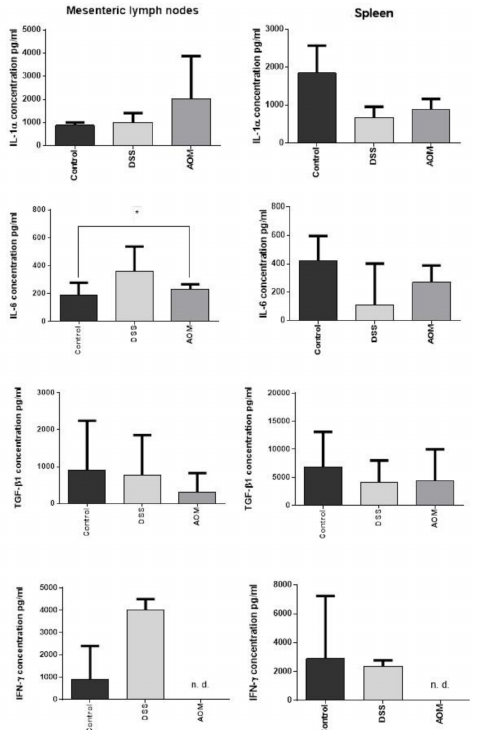
Figure 8. The production of IL-1 α , IL-6, TGF- β 1, and IFN- γ in mesenteric lymph nodes and spleen of DSS- or AOM-induced rats at 1 month from the end of treatments. The cytokine production in MLNs and spleen was indicative of the impact of DSS and AOM on immunity at systemic level. Signs of inflammatory activation were present in MLNs, even at a non-significant level, except for IL-6 after AOM ( p < 0.05). Reduction (even though not reaching significance) of inflammatory cytokines and (at a lesser extent) TGF- β 1 was observed in the spleen. IFN- γ resulted in being not detectable (n.d.) in AOM-treated groups. ELISA values are expressed in pg/mL. Significance was evaluated